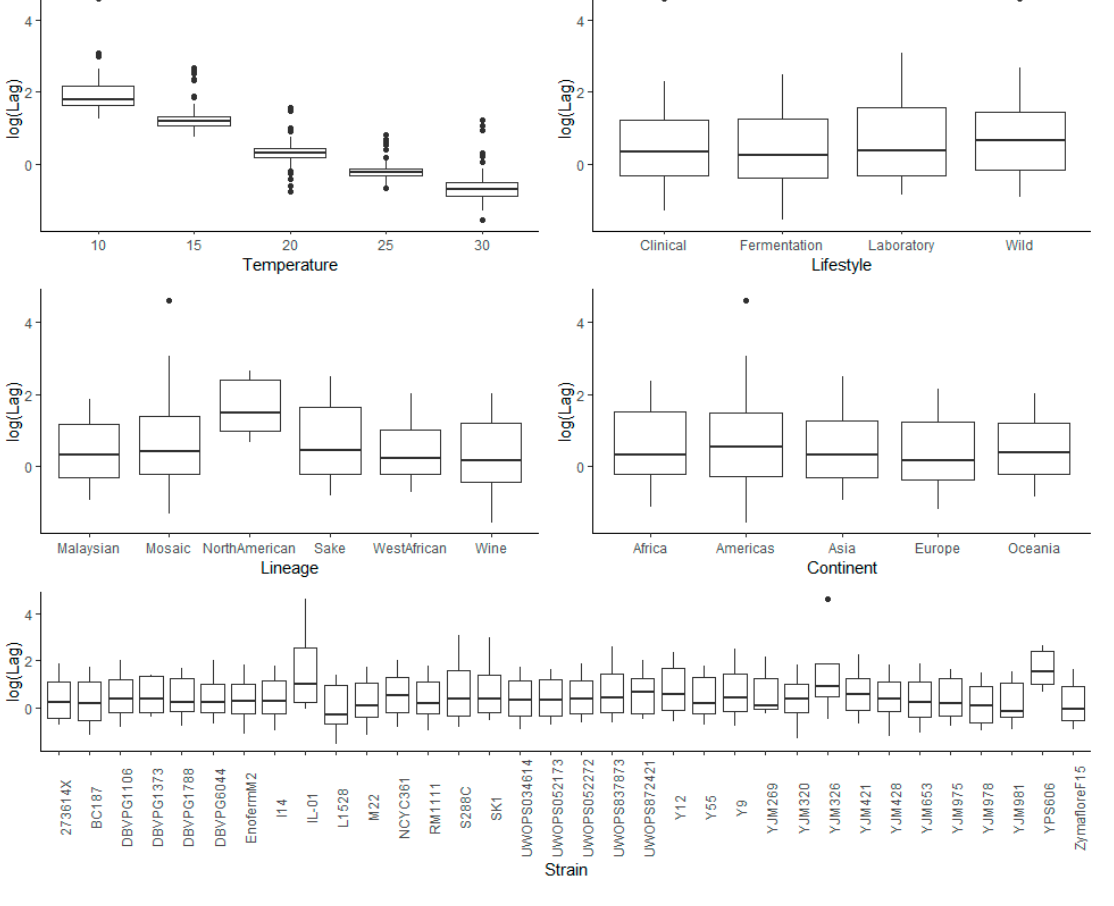
Figure 3. Box plots exploring the relationships between the log-transformed lag and each of the factors explored in this investigation (temperature, lifestyle, lineage, continent, and strain).